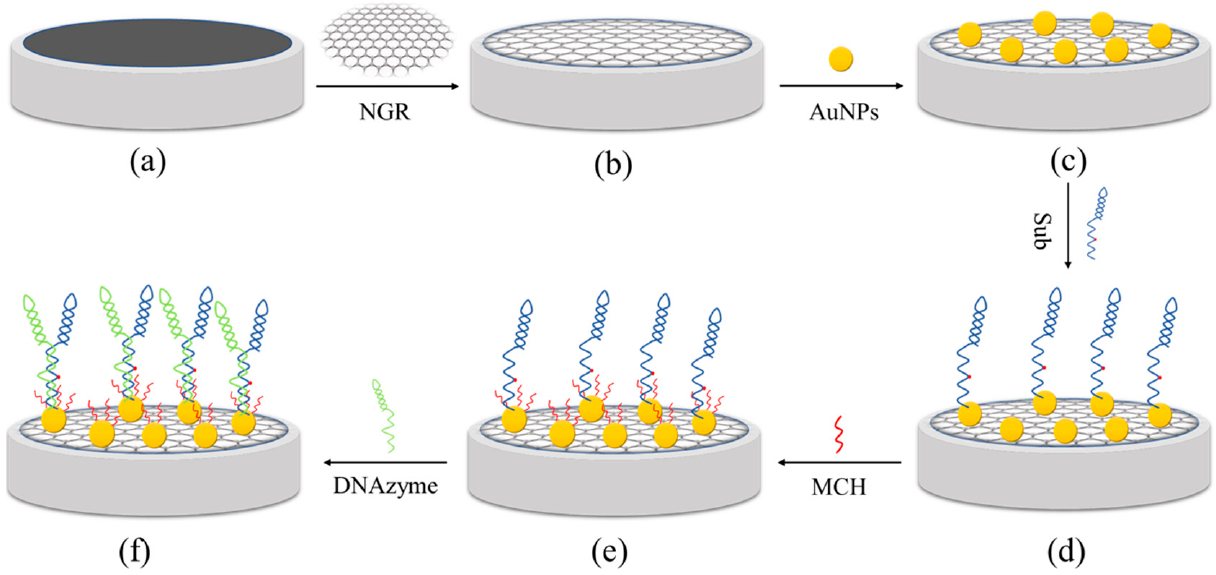
Figure 1. The process of GCE ( a ) functionalized with NGR ( b ), AuNPs ( c ), Sub ( d ), MCH ( e ), and DNAzyme ( f ).